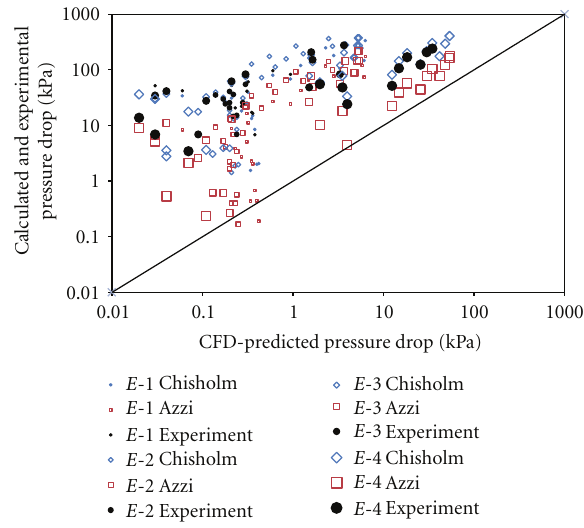
Figure 5: Comparison of CFD versus calculated and experimental pressure